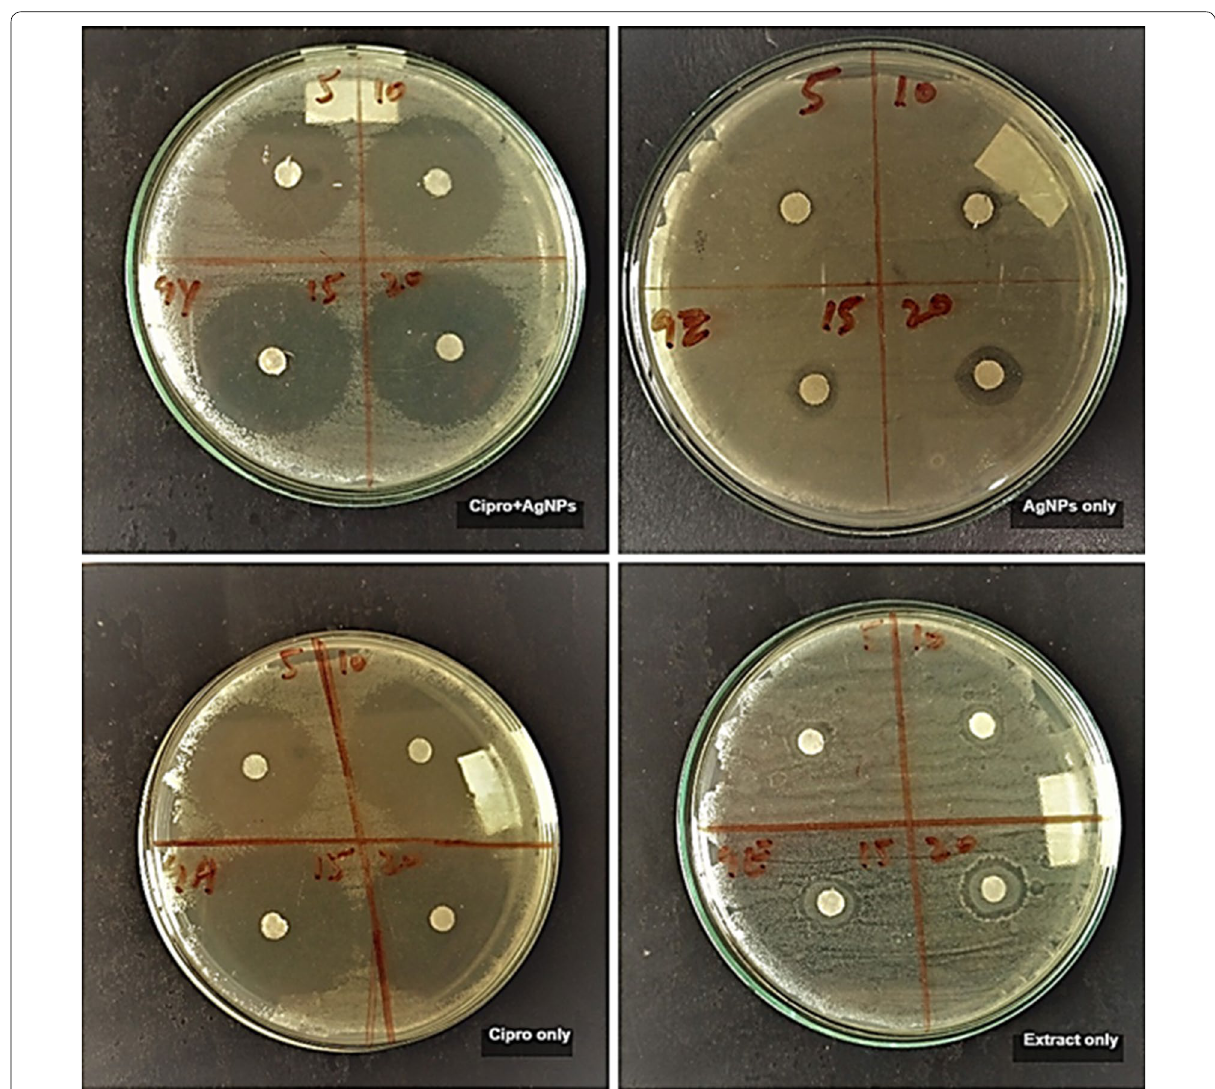
Fig. 6 Activity of ciprofloxacin callus extract mediated AgNPs, callus extract mediated AgNPs, ciprofloxacin only and extract only controls against + Shigella